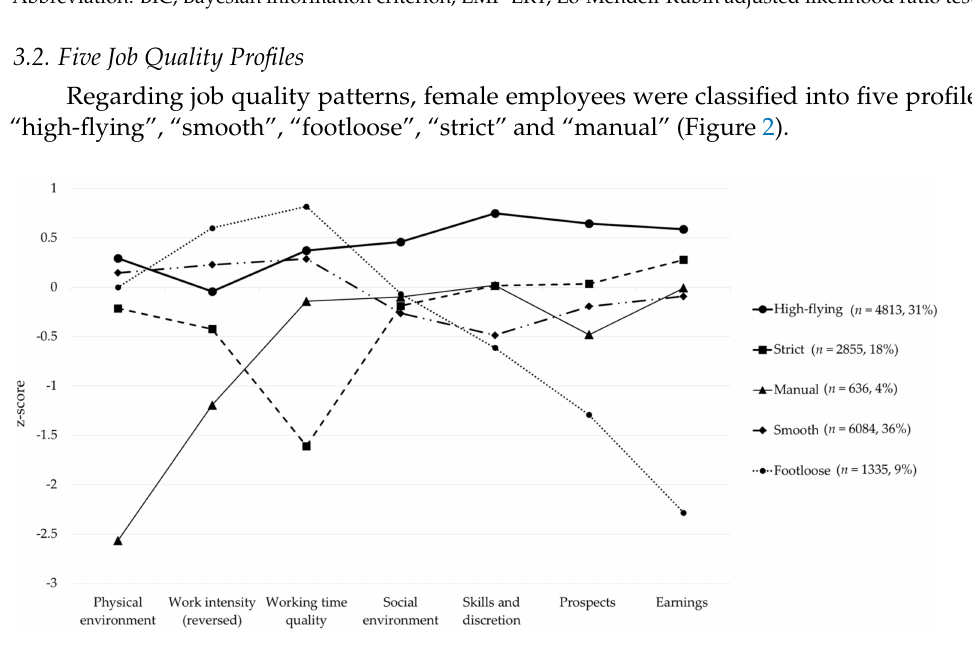
Figure 2. Five job quality profiles by job quality